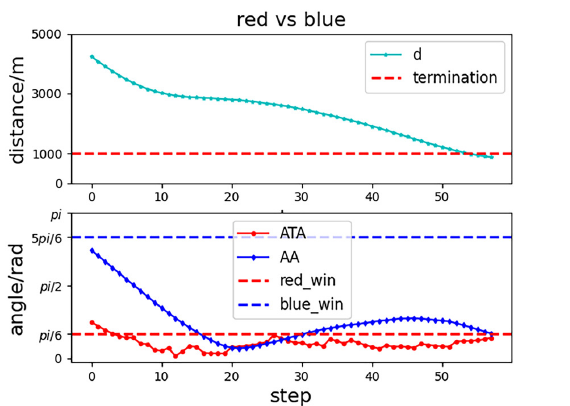
Figure 16. The changes of ATA , AA and d in the later training period in case